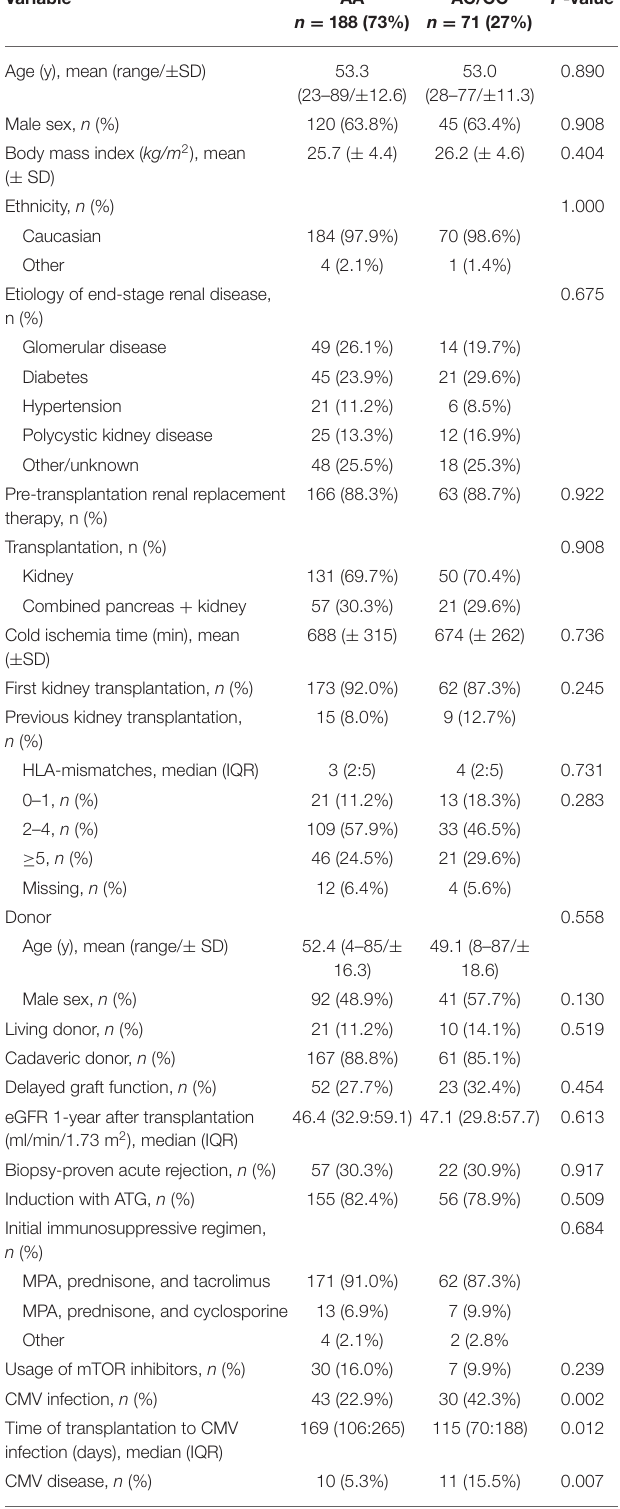
TABLE 1 | Characteristics of kidney transplantation patients ( n = 259) at baseline stratified by AQP5 − 1364 A/C genotype.